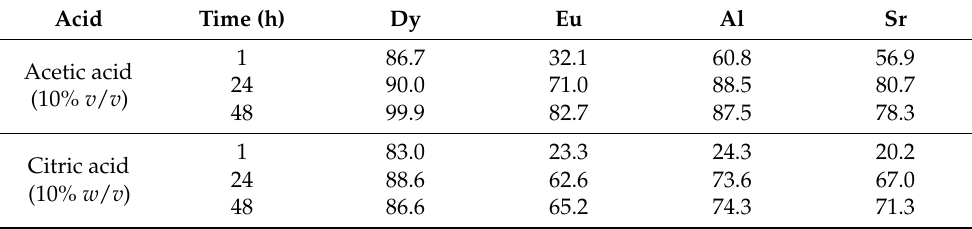
Table 4. Direct acid leaching efficiency (EFF%) of each metal from SRA phosphor